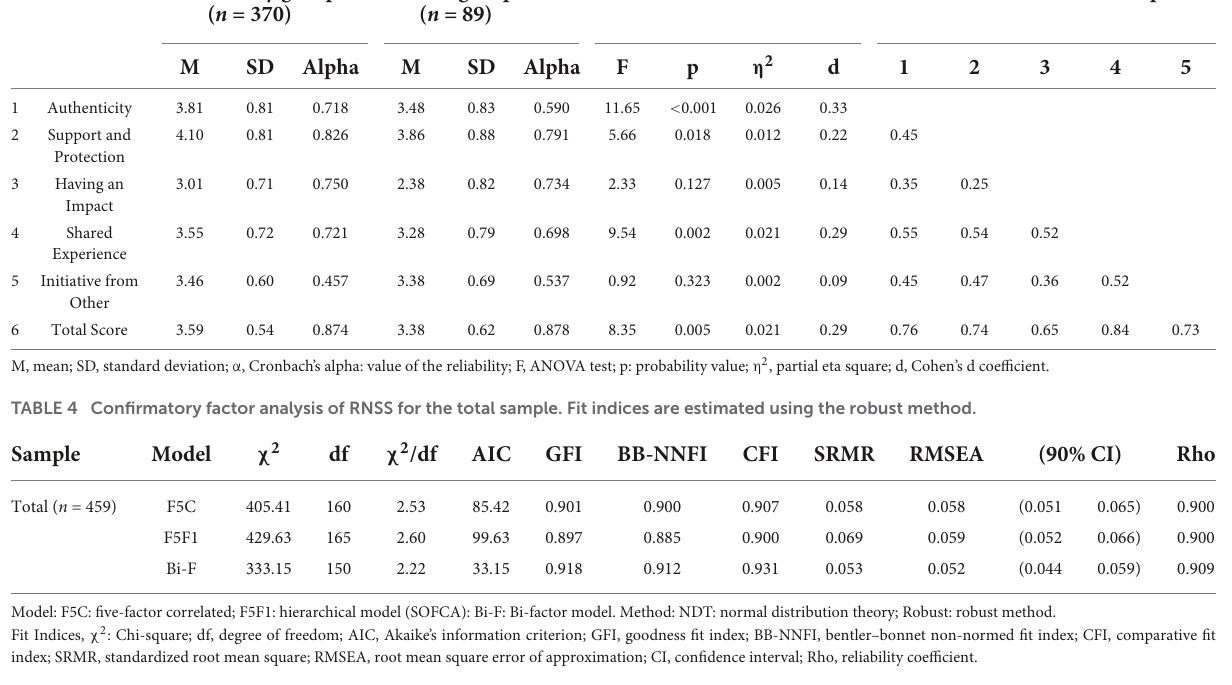
TABLE 3 Descriptive statistics and reliability for each sub-sample, intergroup contrast, and correlations between RNSS scales for total sample ( n = 459). Community group Clinic group ANOVA and effect sizes Correlation for total sample ( n = 370) ( n = 89)